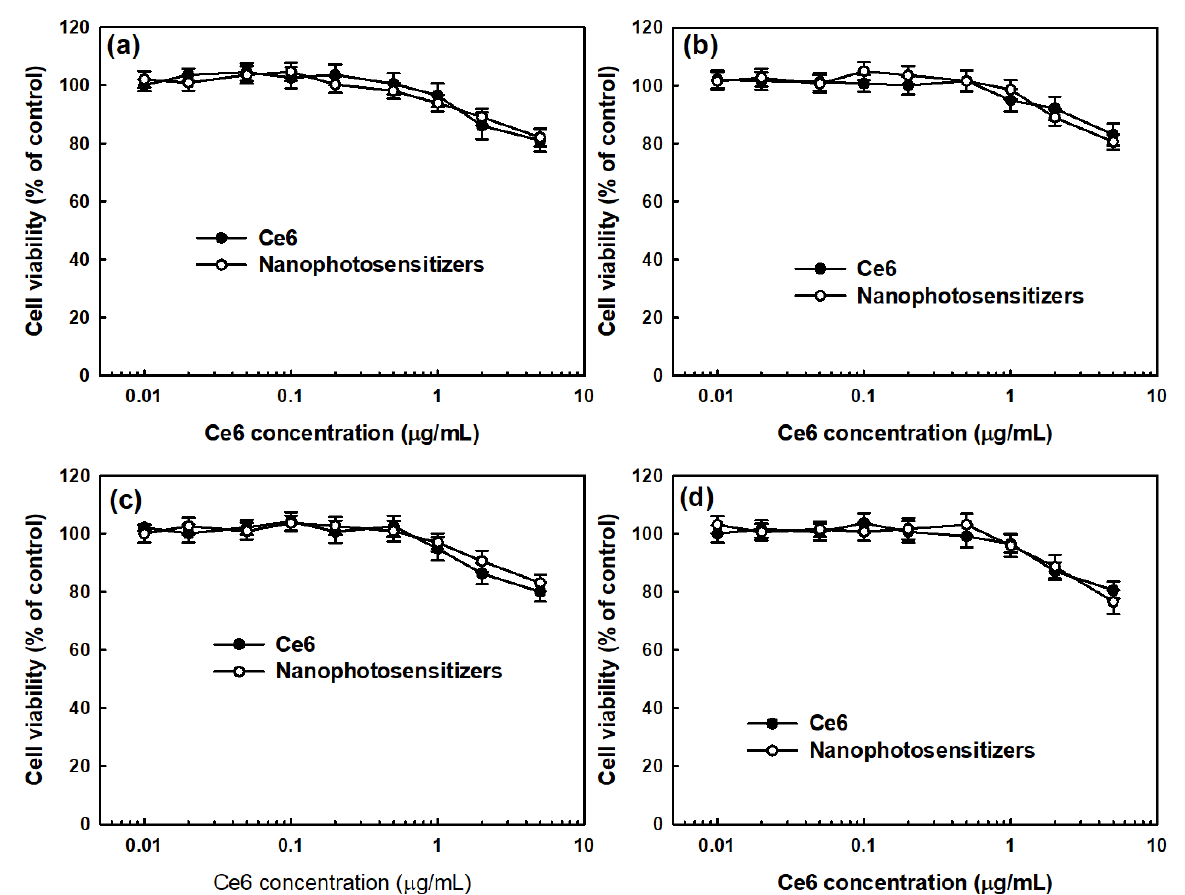
Figure 8. Dark toxicity of free Ce6 and nanophotosensitizers. ( a ) YD-38 cells. ( b ) KB cells. ( c ) SCC-15 cells. ( d ) HGF-1 cells. The results are the average ± standard deviation (s.d.) from eight different experiments.